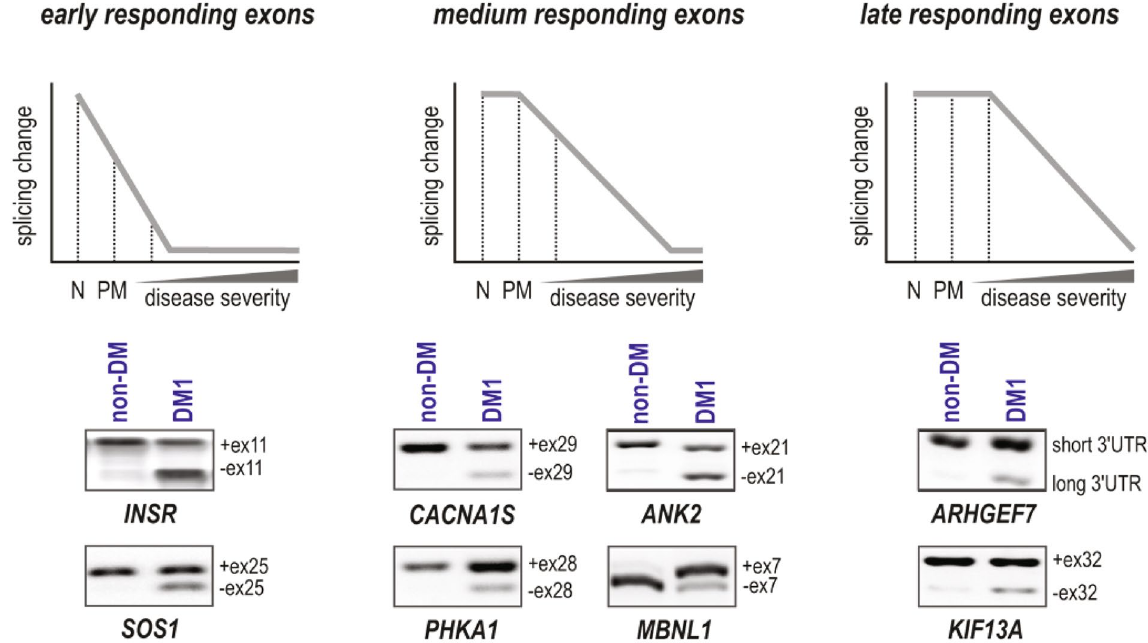
Figure 1. Targets Selected for Analysis of Aberrant Alternative Splicing. Three categories of alternative exons selected are shown: early responding exons ( INSR E11 and SOS1 E25); medium responding exons ( CACNA1S E29, ANK2 E21, PHKA E28 and MBNL1 E7), and late responding exons ( KIF13A E32 and ARHGEF7 3 ′ UTR). N, normal samples; PM, samples from pre-mutation carriers and DM patients with increasing disease severity. The agarose gel separation of representative RT-PCR products for alternative exon inclusion and exclusion in non-DM (sample 6A, female, tibialis anterior) and DM1 (sample 3A; adult onset, male, tibialis anterior; 390 CTG repeats) is